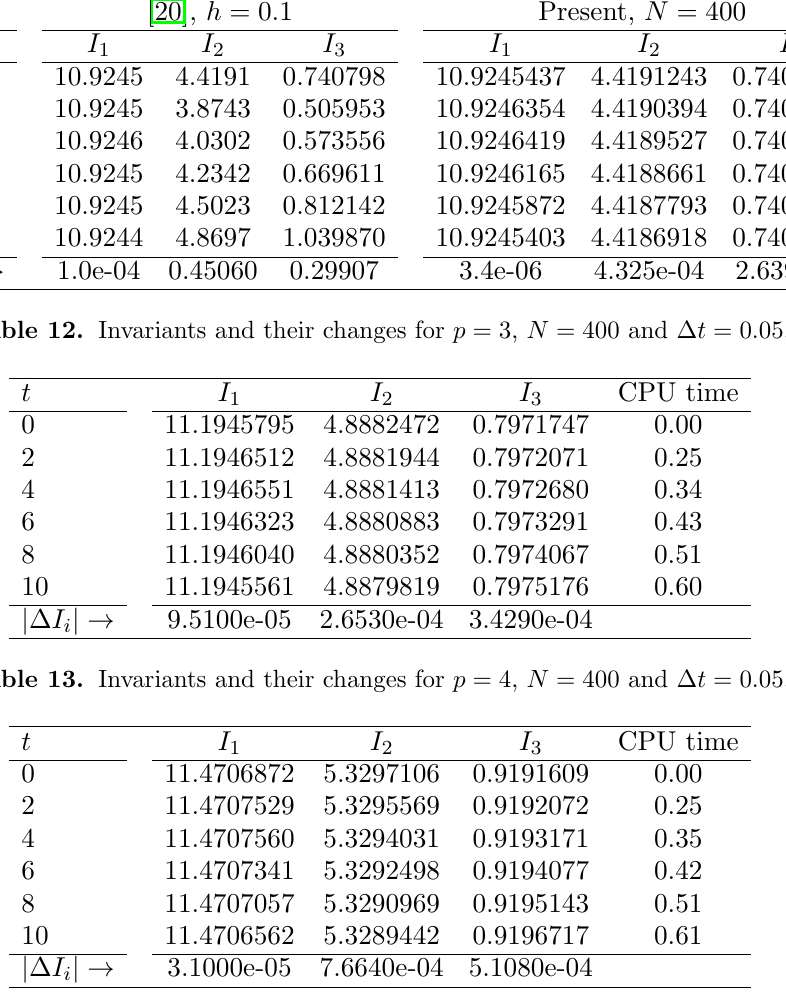
take N = 400, ∆ t = 0 . 005 for the present